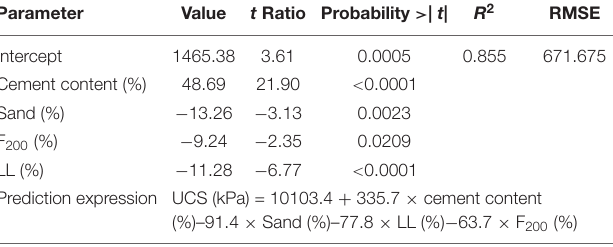
TABLE 5 | Multi-variate analysis results to predict unsaturated UCS.